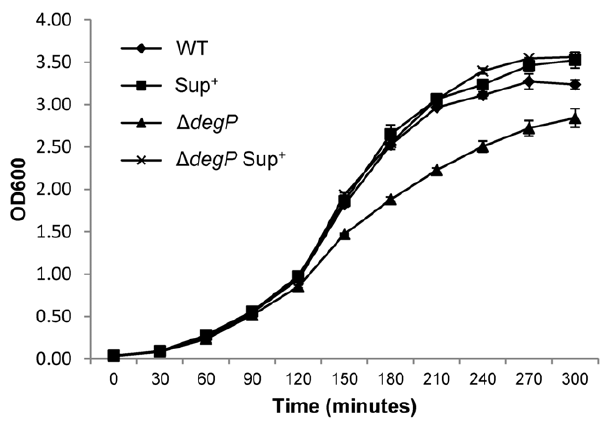
Figure 2. Growth curves of bacterial cultures grown at 39 6 C. Wild type and D degP cells, with or without the suppressor mutation, were grown overnight at 30 u C. Next day, overnight cultures were diluted to 1:100 in flasks containing fresh, pre-warmed, Luria broth and growth was resumed at 30 u C and 39 u C. OD 600 was measured from bacterial samples withdrawn every 30 minutes. Only 39 u C growth curves, obtained from two independent experiments, are shown. All strains grew almost identically at 30 u C.